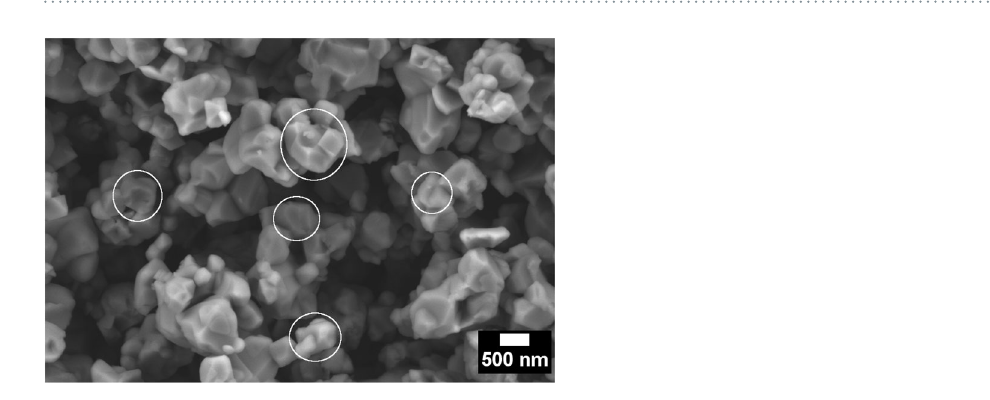
Figure 7. Particle size distribution for LTO ( a ); LTO after sonication without centrifugation ( b ) and nLTO ( c ).